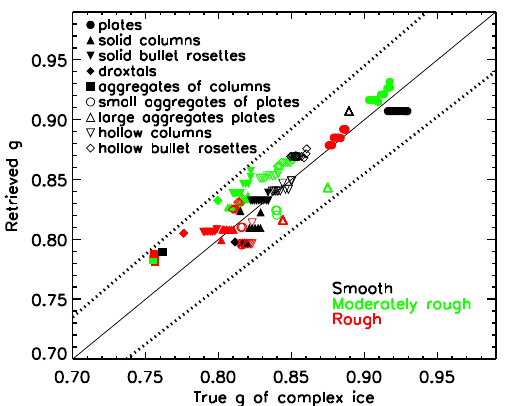
Fig. 6. As for Fig. 4, but for simulated data assuming various ice crystal habits indicated by symbols. Black, green and red colors are results for simulated data assuming smooth, moderately rough, and severely rough particles, respectively. For each combination of roughness and habit, 10 different size distributions are applied (see